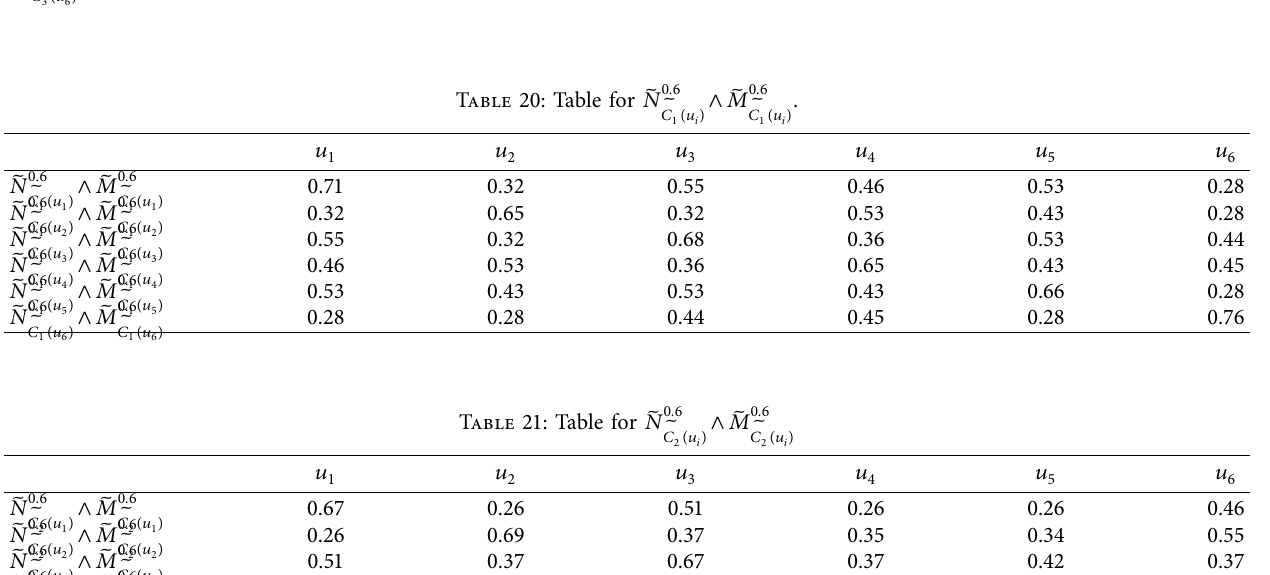
Table 21: Table for 􏽥 N 0 . 6 􏽥